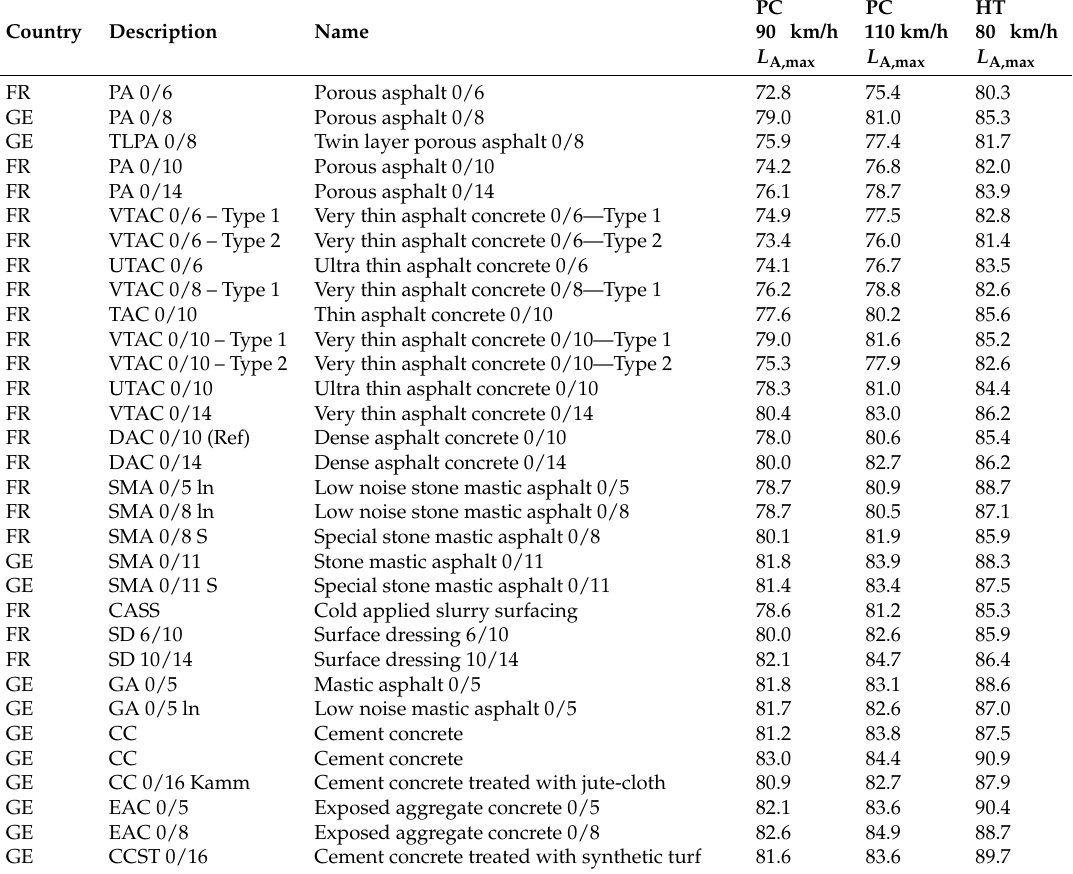
Table 2. Pavement database: L A,max sound levels for road vehicles, at 90 or 110 km/h (PC) and 80 km/h (HT). French and German pavements are noted with the FR and GE notations respectively. The numbers after the pavement description corresponds to the minimum/maximum size of the aggregates. In addition, the ‘type’ defines the porosity properties; ‘Type 1’ means a porosity Ω lower or equal than 15% and ‘Type 2’ a porosity means Ω between 15% and 25%. As an example, ‘VTAC 0/6 Type 2’ corresponds to a very thin asphalt concrete (VTAC) with aggregate sizes between 0 and 6 mm and a porosity close to